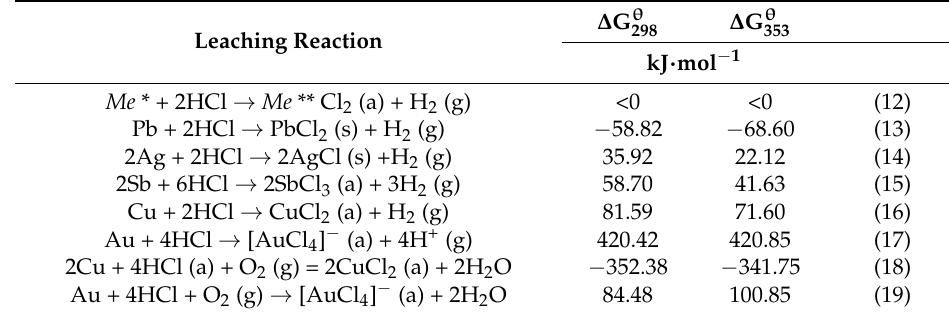
Table 4. ∆ G θ possible chemical reactions of metals with